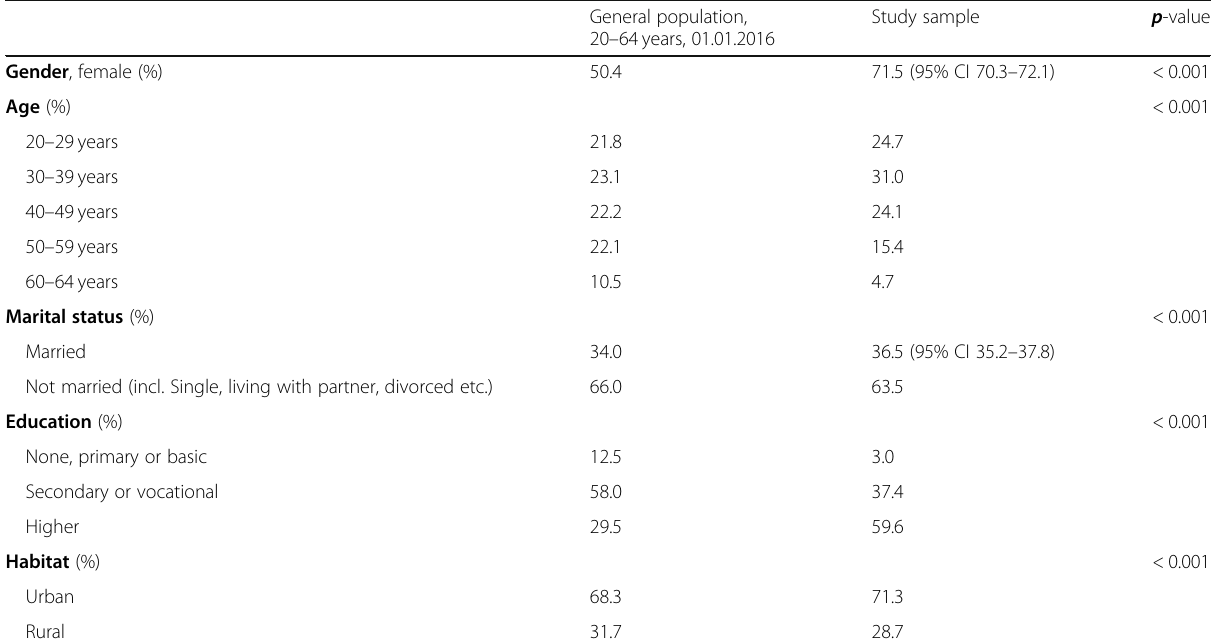
Table 1 Comparison of Estonian population and survey